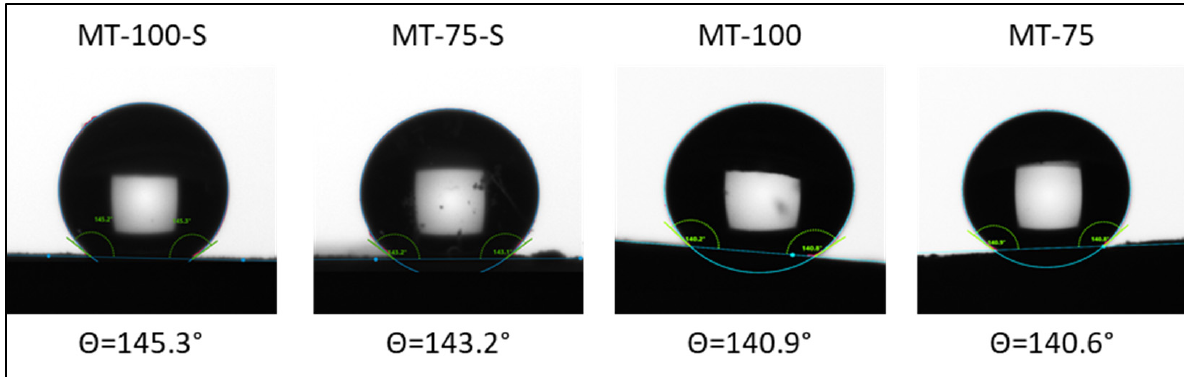
Figure 9. Water contact angles of the silica xerogels.